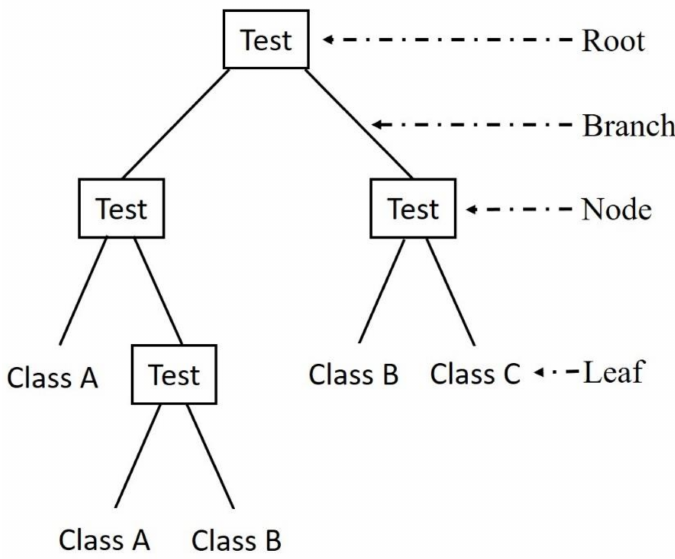
Figure 7. A conceptual illustration of the DTC